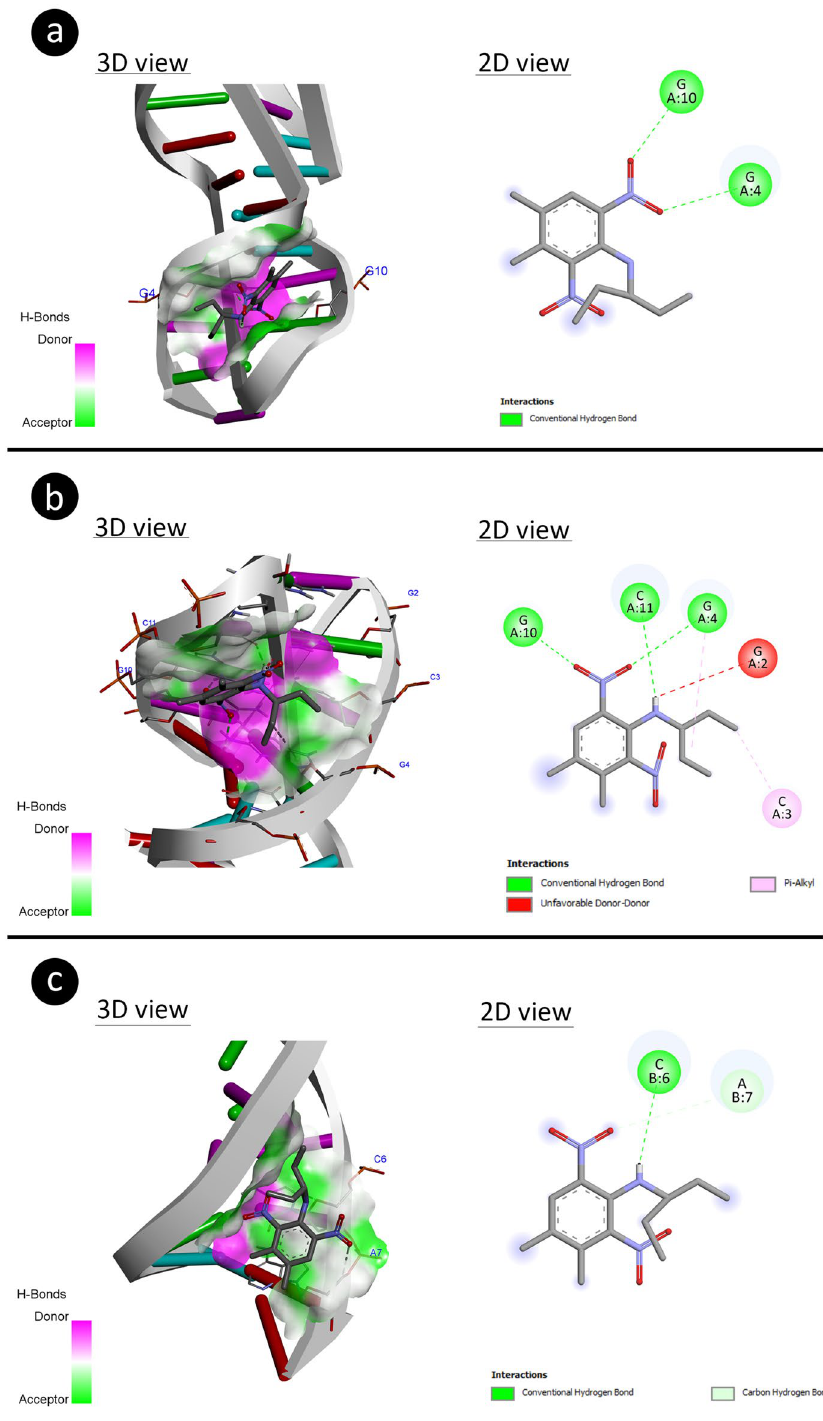
Figure 6. The 3D structural interaction of pendimethalin-DNA through different patterns for potential DNA disruption ( a : 1BNA-pendimethalin, b : 195D-pendimethalin, c :